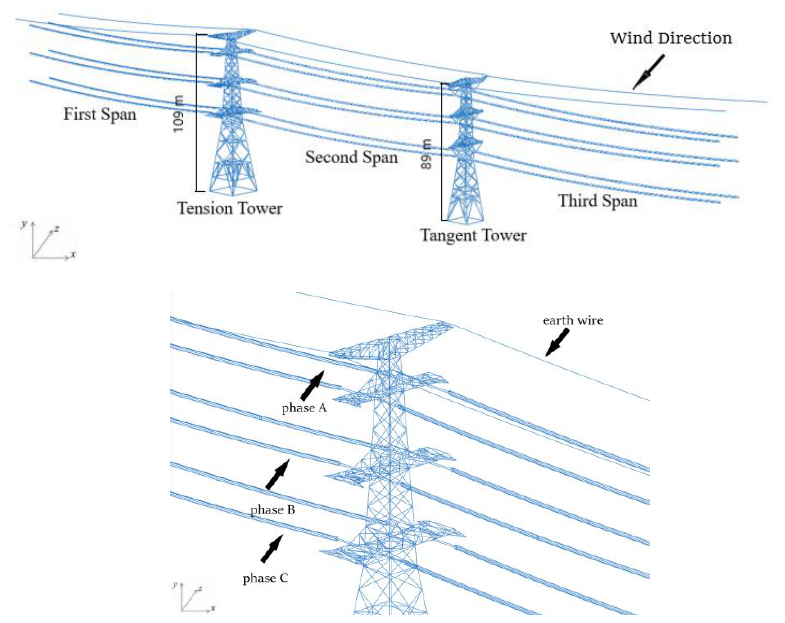
Figure 1. Multi-span iced eight-bundle conductor tower line system finite element model.